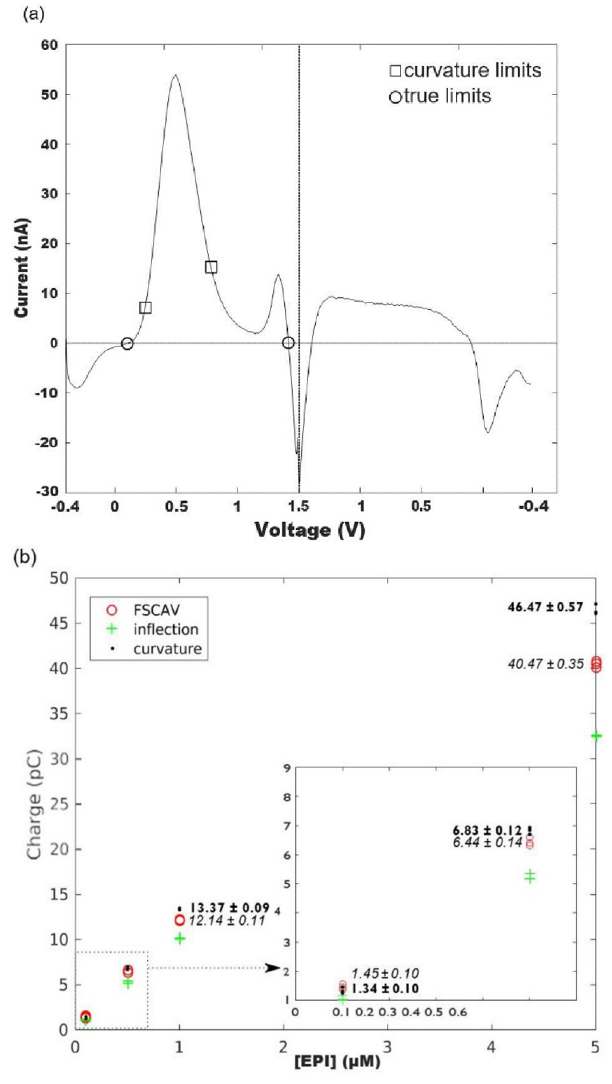
Fig 4. a) A 1 μ M epinephrine voltammogram showing primary and secondary oxidation peaks, superimposed with curvature and true integration limits. b) Primary-peak oxidation charges for a flow cell experiment with 15 injections of epinephrine at different concentrations, obtained with different pairs of integration limits. Averages and standard deviations for charges using FSCAV (in italic) and curvature (bold) integration boundaries are also shown. Quantities shown in the figure indicate averages ± standard